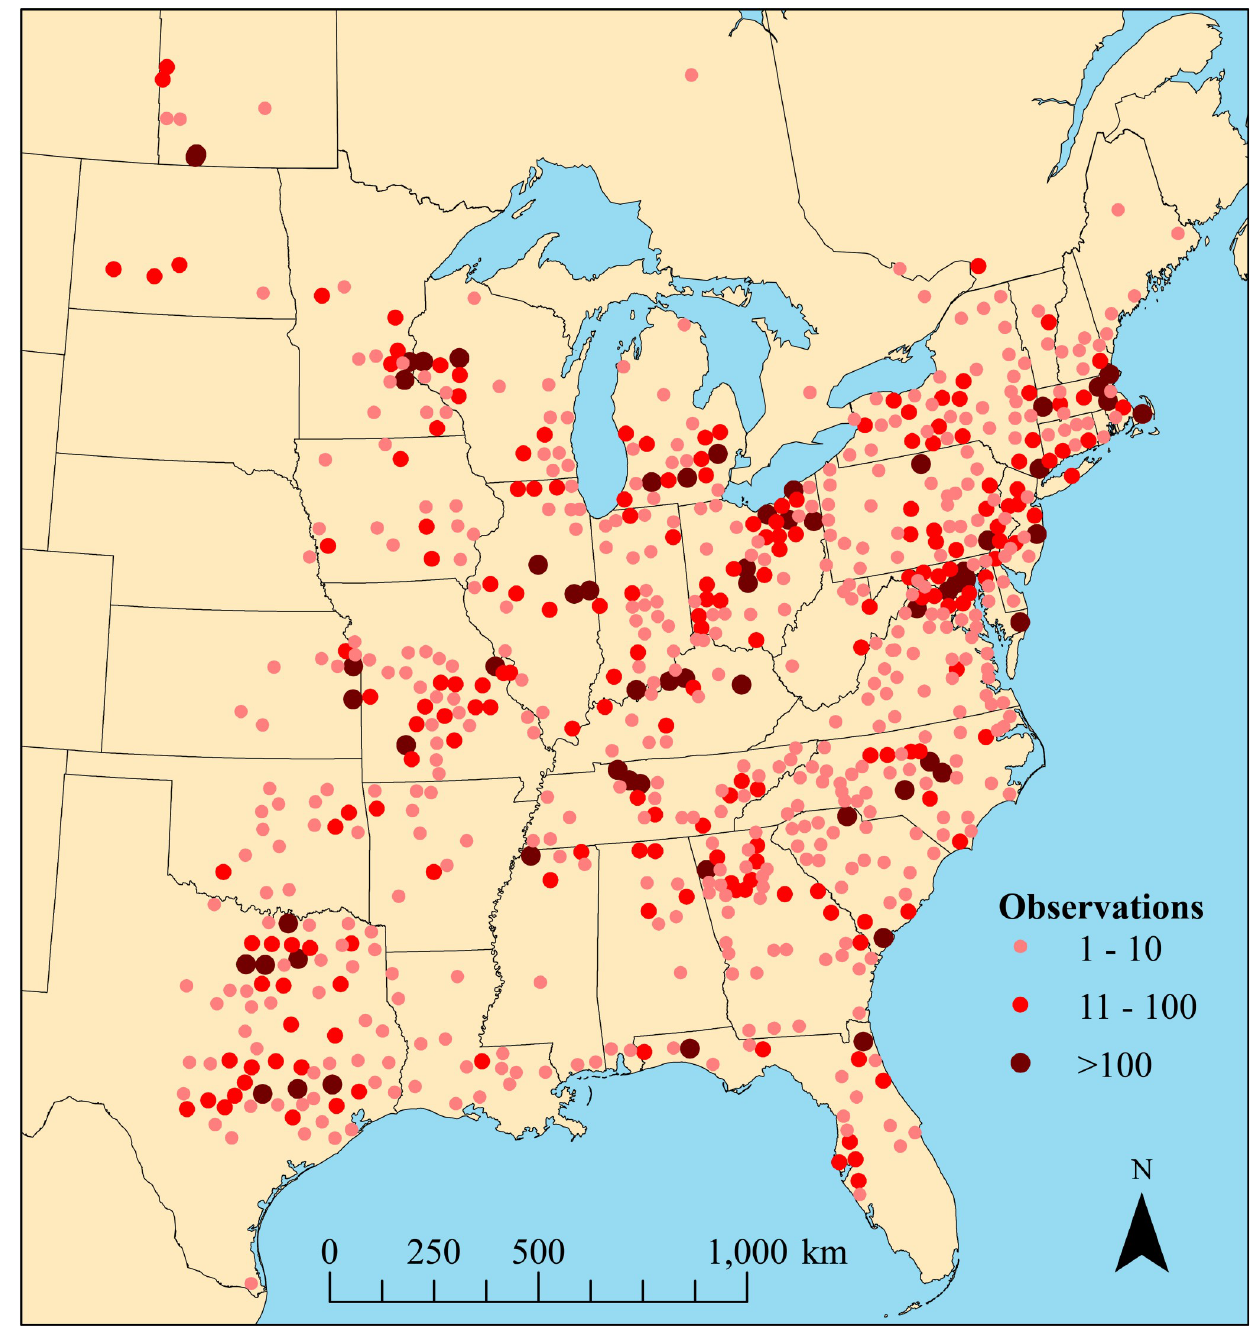
Fig 2. NestWatch observation sites within the North American breeding range of Eastern Bluebirds ( Sialia sialis ), 2006–2013. Created in ArcGIS 10.5.1 with mapping data obtained from the Canadian Open Government portal and U.S. Census Bureau public domain